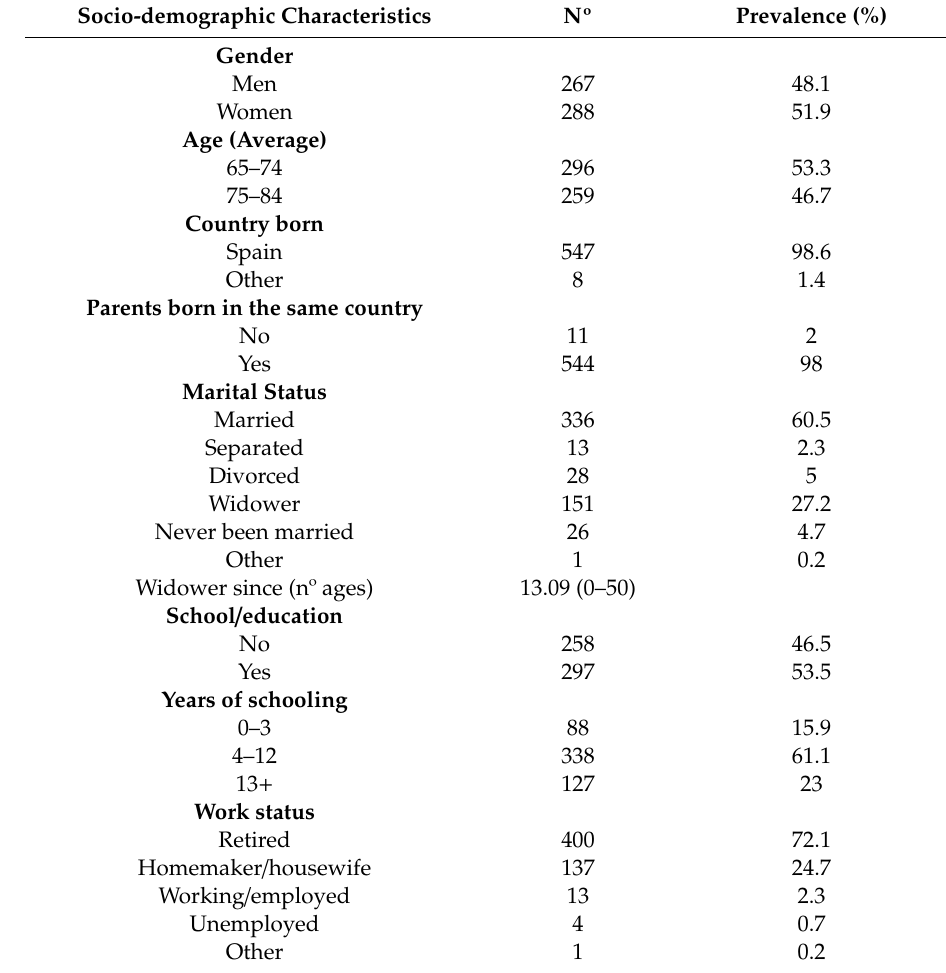
Table 1. Sociodemographic characteristics of the sample (N =